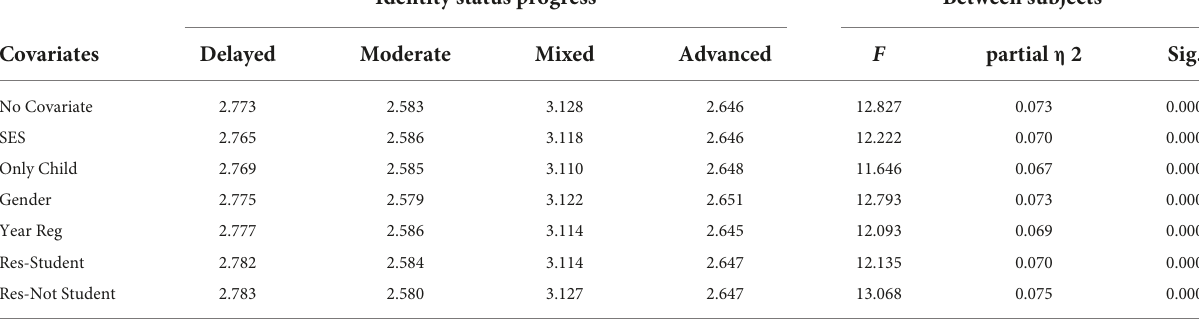
TABLE 3 Summary of estimated marginal means and between subject effects with and without controlling for the effects of covariates. Identity status progress Between